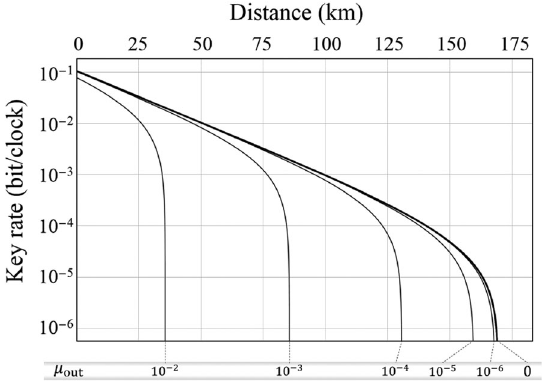
10. Asymptotic key rate R (cid:4)(cid:4) versus distance for the single- photon efficient BB84 protocol, under a THA with unambiguous state discrimination by Eve. The rate is plotted for various values of the parameter μ . Parameters in the simulation are as in Fig. 3. out